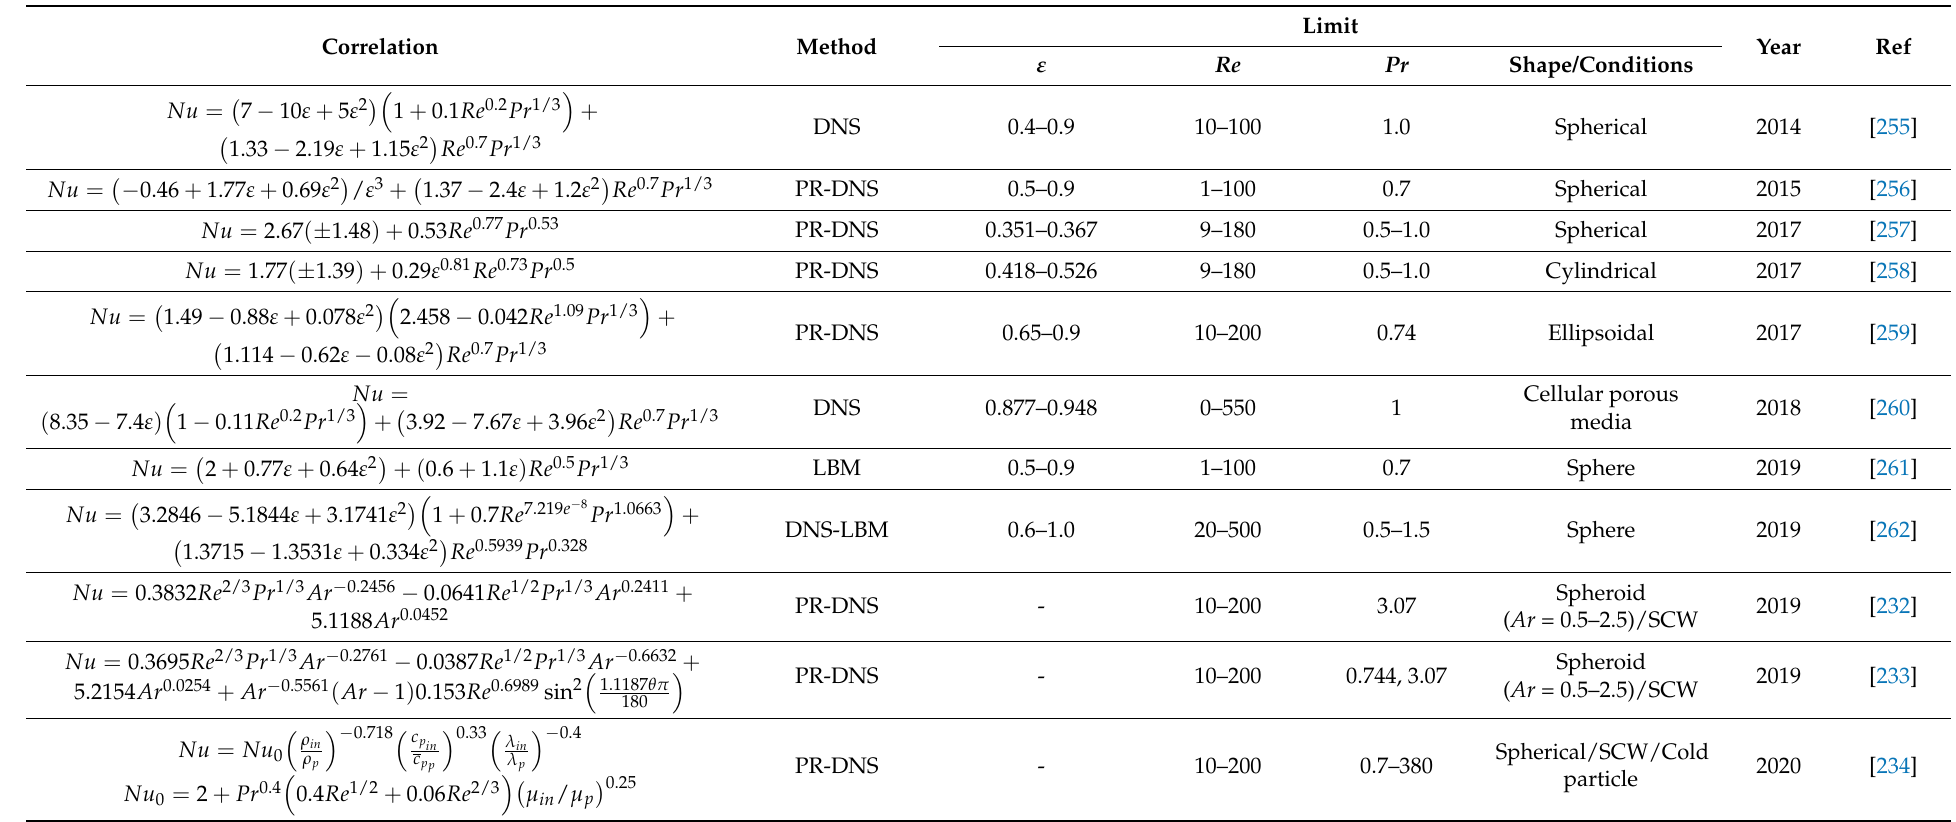
Table 4. Recently developed Nusselt correlations via numerical methods for the particle-fluid systems (Adopted from Ref. [223]). Reprinted from Chemical Engineering Journal, Vol. 374, Li-Tao Zhu, Yuan-Xing Liu, Zheng-Hong Luo, An enhanced correlation for gas-particle heat and mass transfer in packed and fluidized bed reactors, Pages No. 531–544, Copyright (2019), with permission from